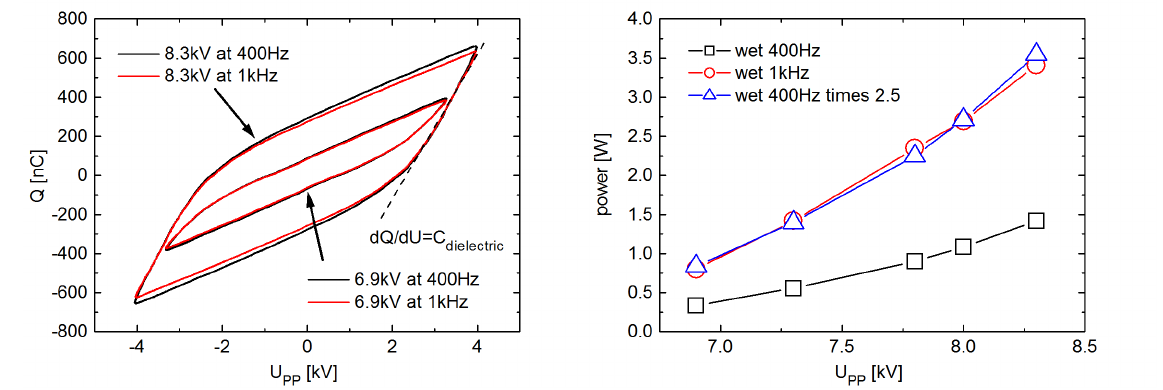
Figure 2: Left: Q-V plots recorded at 8.3 kV and 6.9 kV at 400 Hz and 1 kHz under wet conditions; Right: Power input under wet conditions at 400 Hz and 1 kHz and at 1 kHz calculated based on the power input at 400